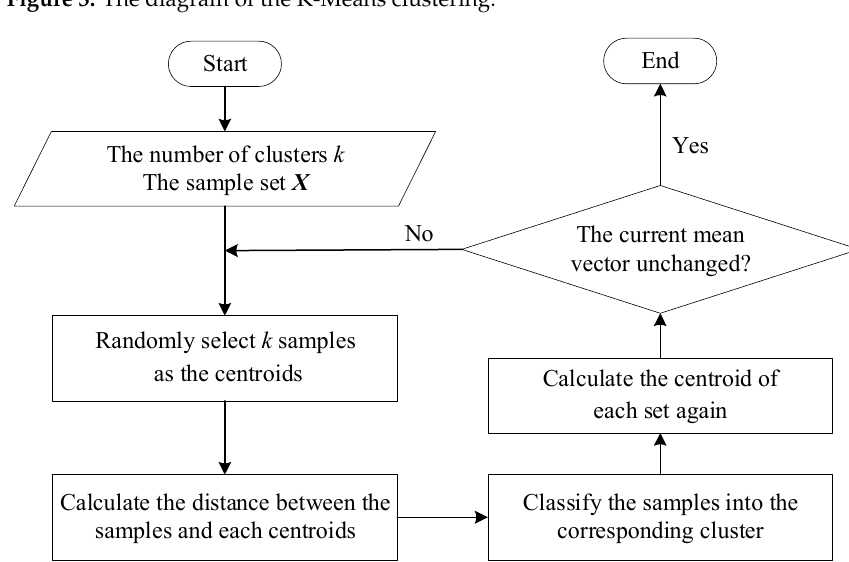
Figure 3. The diagram of the K-Means clustering.